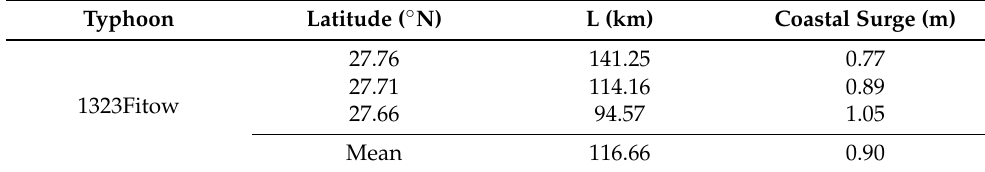
Table 3. Cross-shelf decaying scale and coastal surge; fitting Jason-2 data for Typhoon 1323Fitow.